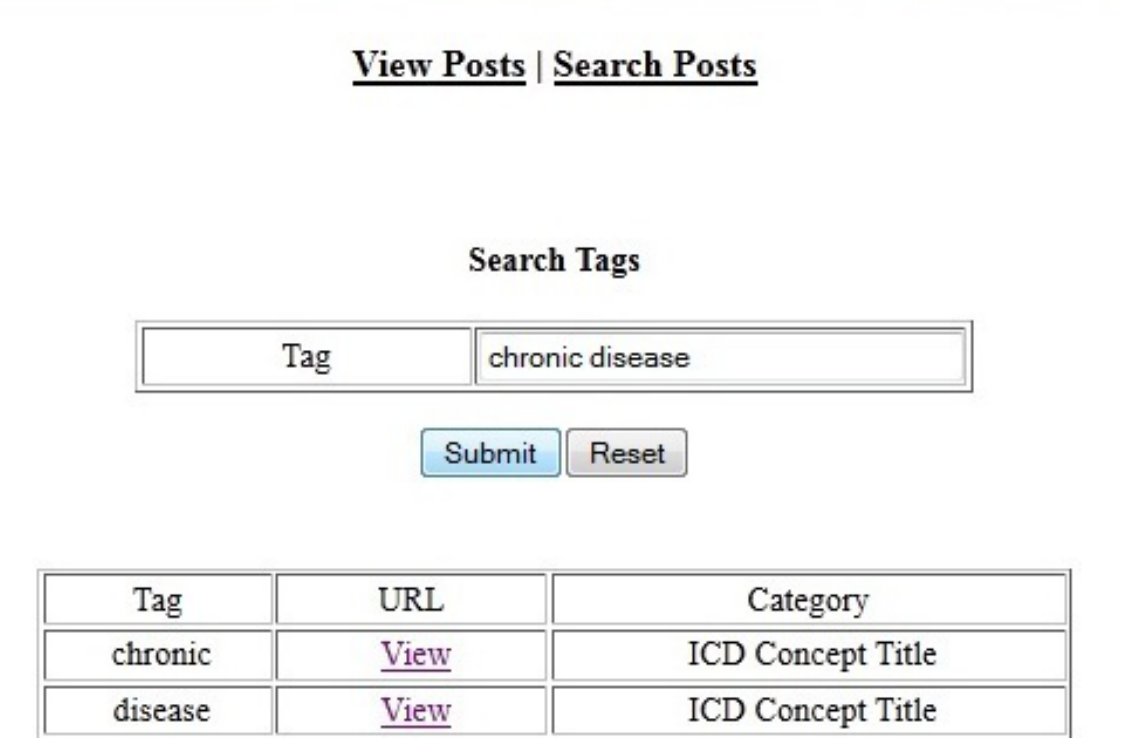
Figure 10. An example of a tag